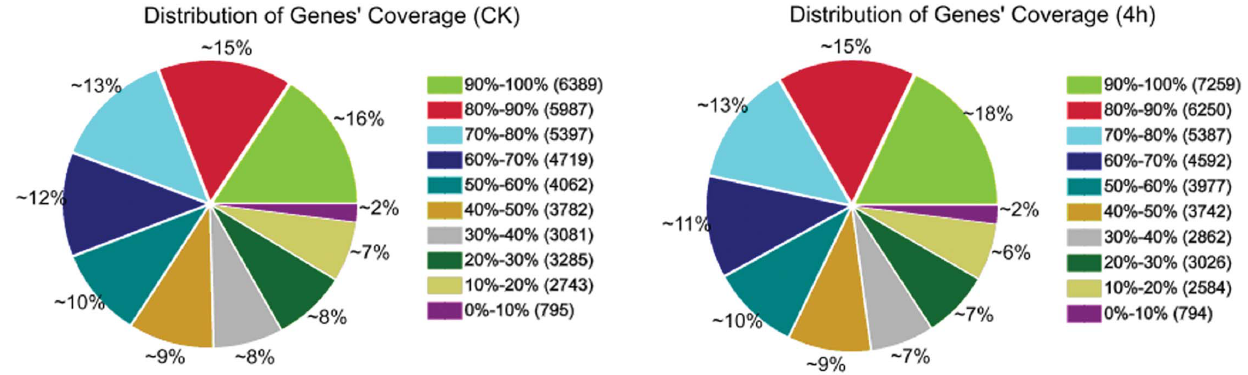
Figure 1. Distribution of genes’ coverage in each library.